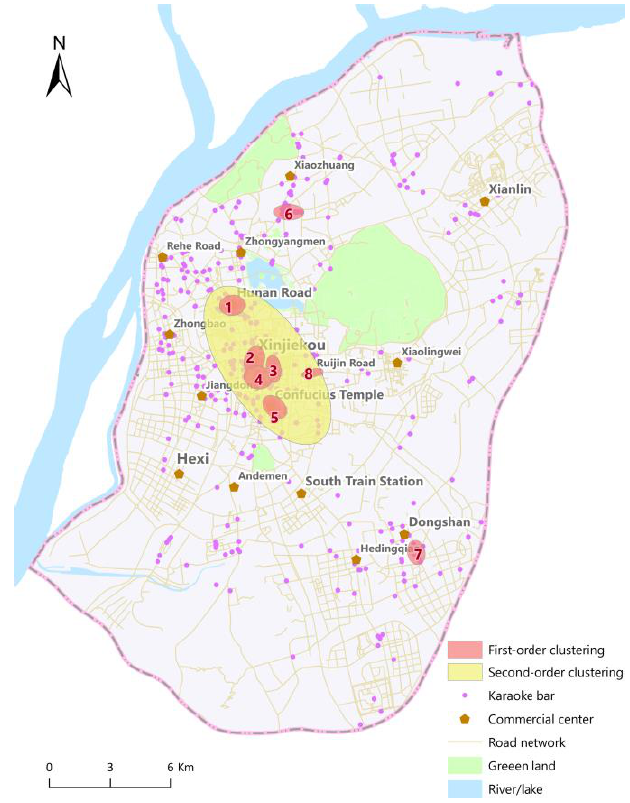
Figure 6. Clusters of karaoke bars.